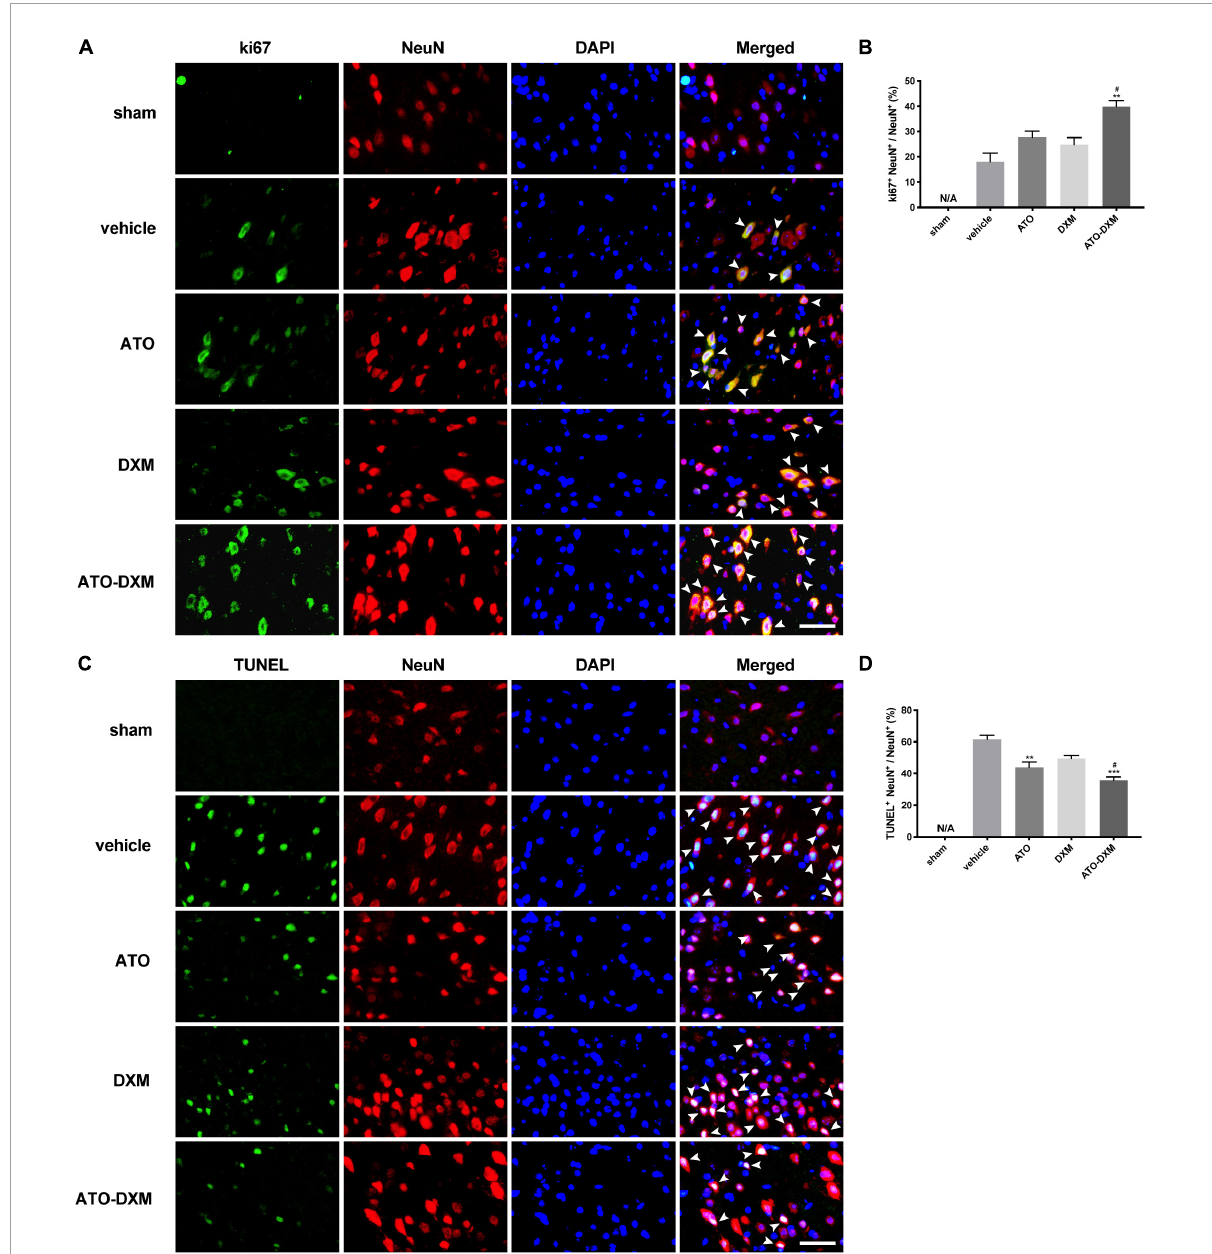
FIGURE8 Immunofluorescence co-staining of neuronal proliferation and apoptosis from the perihematomal on day 3 after ICH. (A) Co-staining of neuronal proliferation. Fluorescent colors: ki-67, green; NeuN, red; nuclei, blue. Proliferating cells, indicated by arrows, were counted under a fluorescence microscope (original magnification, 400 × ; scale bar, 200 µ m). (B) Statistical comparisons of Ki67 + neuronal cells. (C) Co-staining of neuronal apoptosis. Fluorescent colors: TUNEL, green; NeuN, red; nuclei: blue. Apoptotic cells, indicated by arrows,